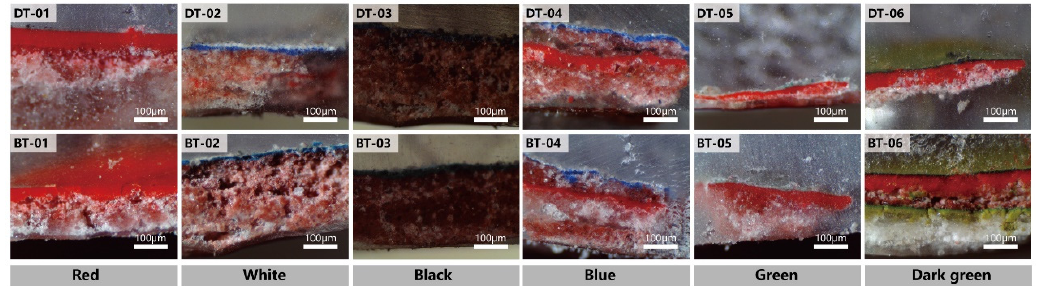
Figure 3. Microscopic section images of the painted samples.